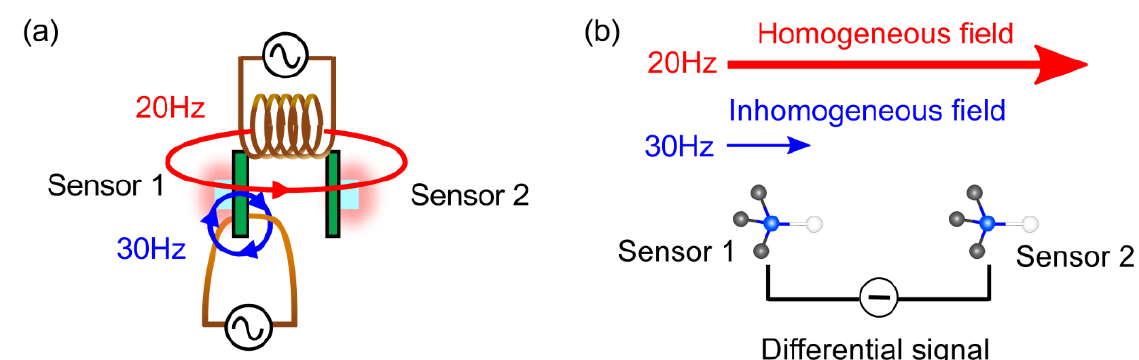
Figure 4. ( a ) Gradiometer with the solenoid coil and the copper wire. The base length of the gradiometer was 27 mm. ( b ) Direction of the magnetic fields and the orientation axis of the NV center.